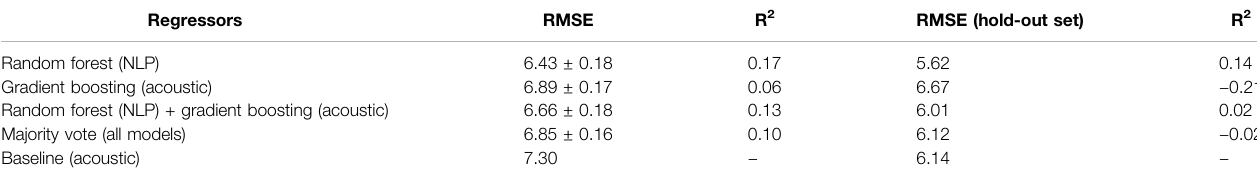
TABLE 2 | Results of our best performing regression models predicting a subject ’ s MMSE score (ranging from 0 to 30, with lower values indicating more severe dementia). The ‘ Baseline(Acoustic) ’ modelisdescribedinLuzetal.(2020).Asin Table1 ,thecolumnsontherightshowRMSEandR 2 ontheheld-outtestsetof48subjects(24AD and 24 non-AD). The middle columns list RMSE and R 2 using 5-fold cross-validation on the training set of 108 subjects (54 AD and 54 non-AD). Regressors RMSE R 2 RMSE (hold-out set) R 2 Random forest